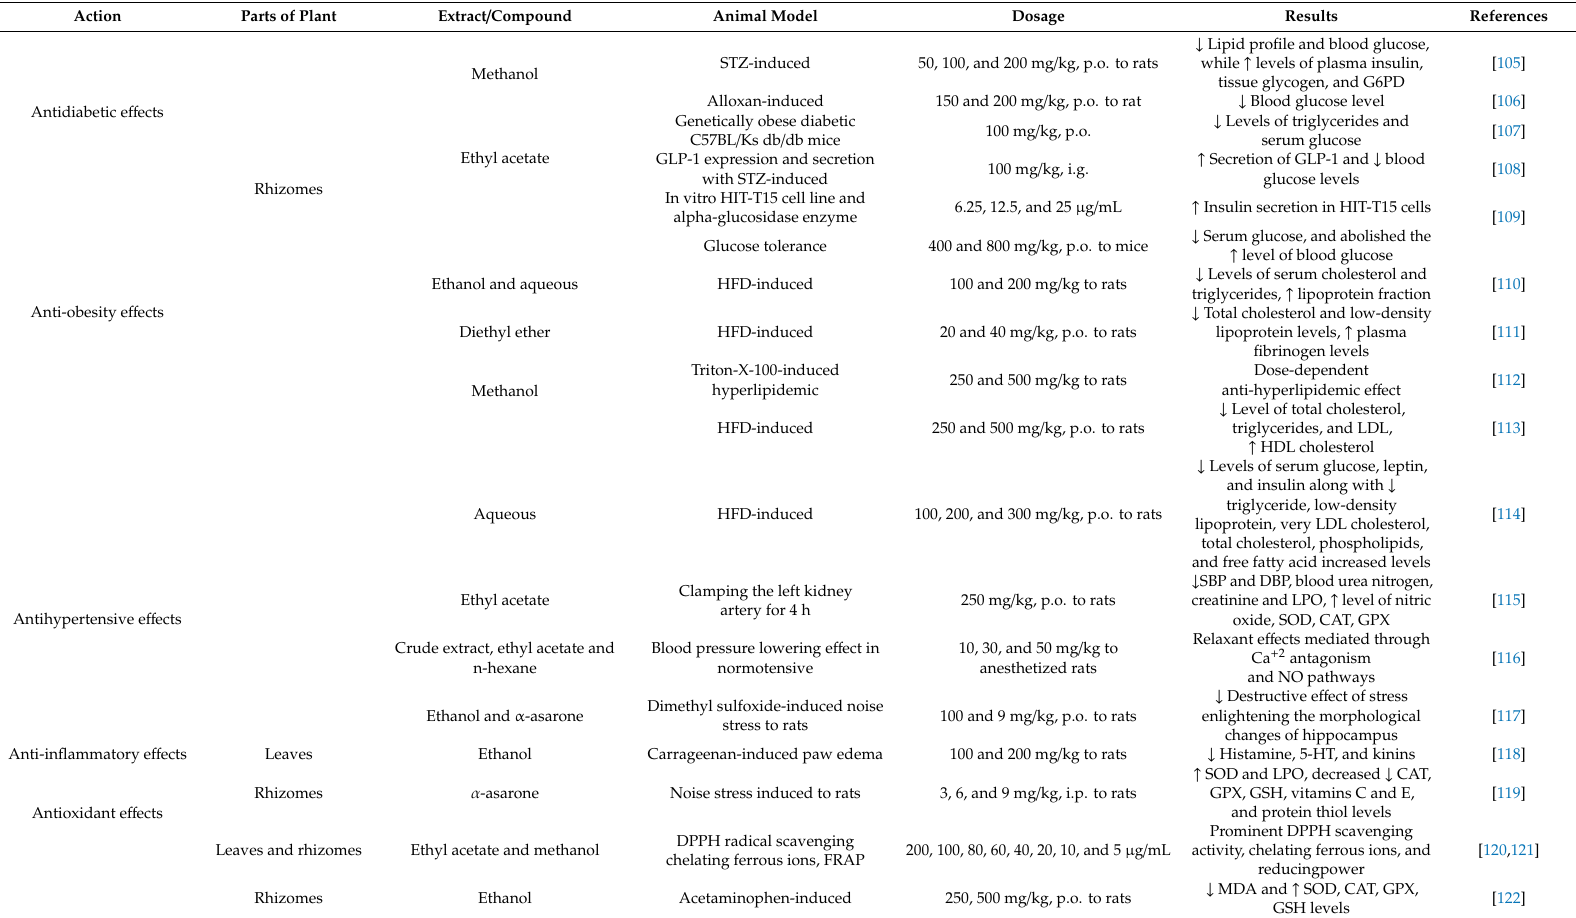
Table 4. Preclinical claims of A. calamus in neurological and metabolic